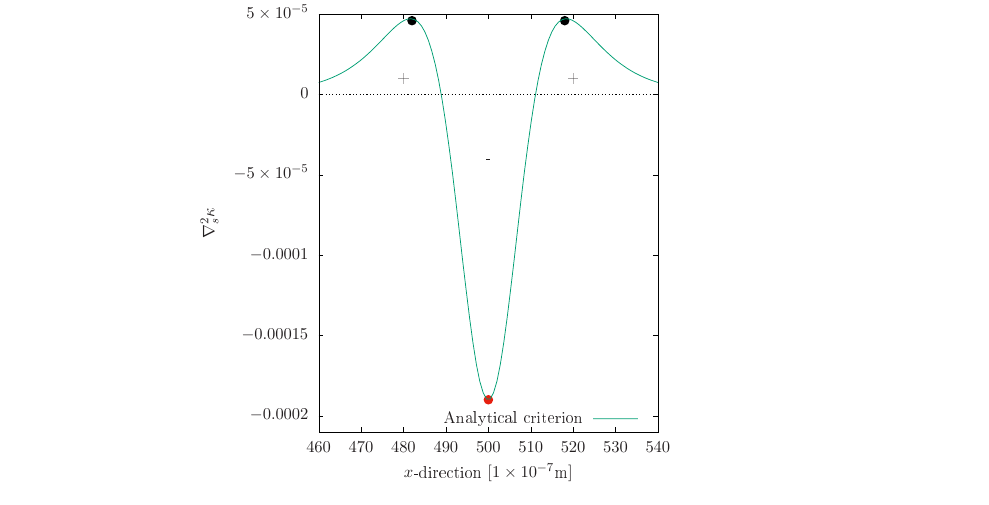
Figure 6. Calculated sharp-interface analytical criterion for α = 0.02 as a function of the grid position. The positive and negative regions indicate the crest and the trough positions during a tip-splitting event. The forked region lies between the 2 > 0 s κ ∇